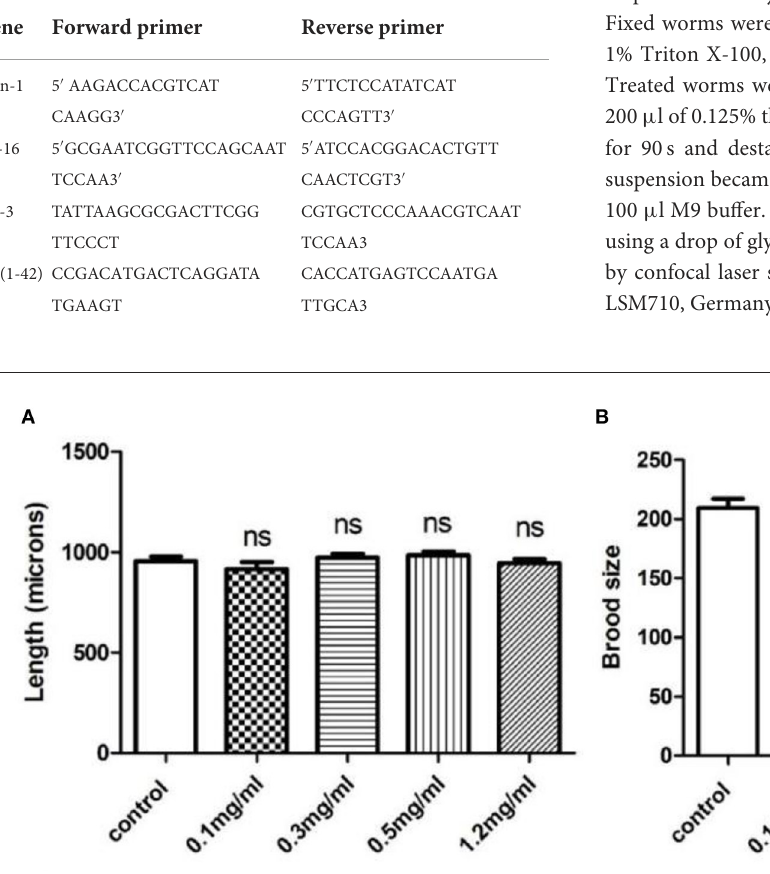
FIGURE1 The effects of Exendin-4 on wild-type N2 Caenorhabditis elegans . (A) Body length assay and (B) brood size assay. There was no significant difference in the treatment groups on brood size and body length. Values are mean ± SEM of experiments repeated independently at least for three